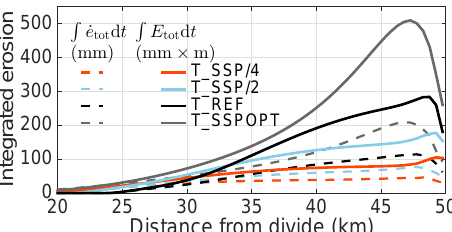
R ˙ e tot d t ) and